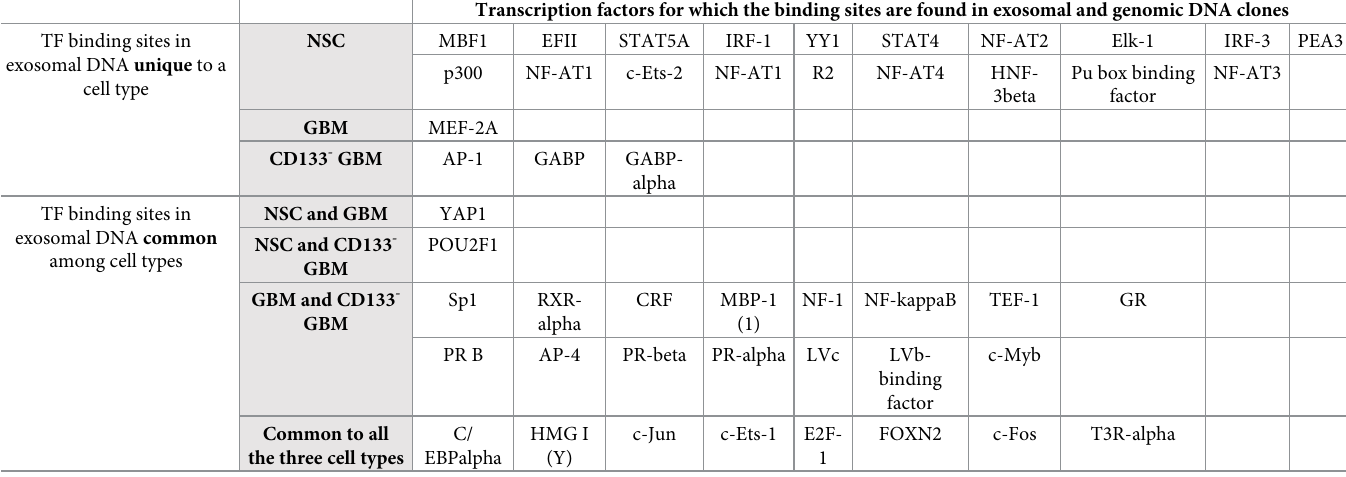
Table 2. Summary of TFs for which the binding sites were found in the exosomal DNA. Transcription factors for which the binding sites are found in exosomal and genomic DNA clones TF binding sites in exosomal DNA unique to a cell type